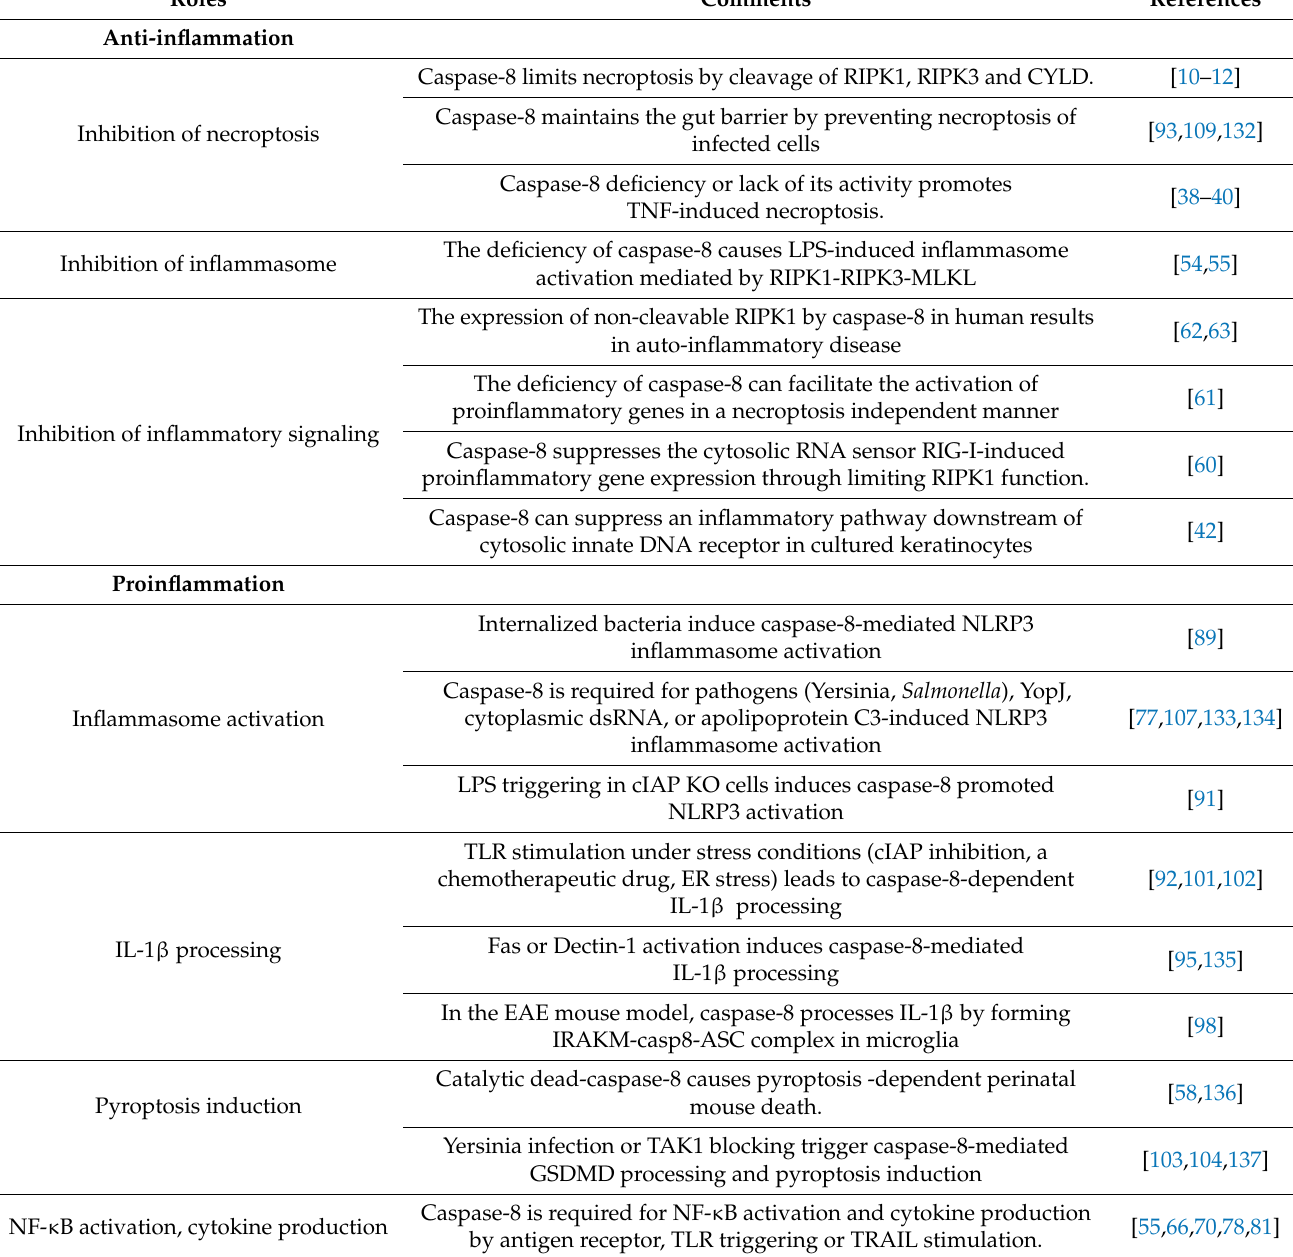
Table 1. Caspase-8–mediated pro-and anti-inflammatory